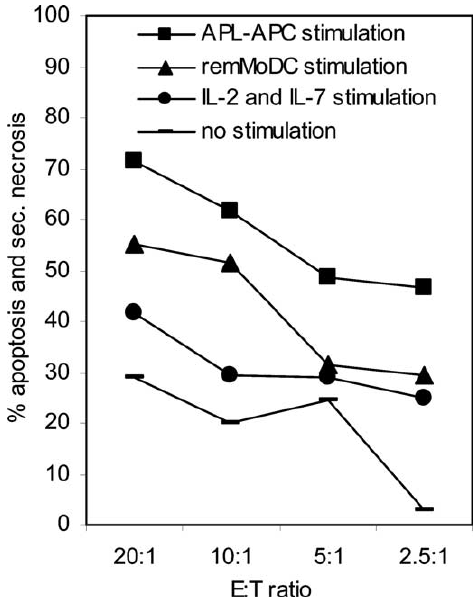
Fig. 3. Cytolytic capacity of autologous remission T cells and rem- MoDC- and APL-APC stimulated T cells towards corresponding au- tologous blast cells. The assay was performed with remission PBL isolated directly after achieving complete remission. Effector to tar- get ratio is depicted on the X-axis; the Y-axis depicts spontaneous apoptosis and secondary necrosis in the leukaemic cell population as assessed by a flow-cytometric cytotoxicity assay [13]. Spontaneous apoptosis and secondary necrosis of the leukaemic blast cells in the APL sample was